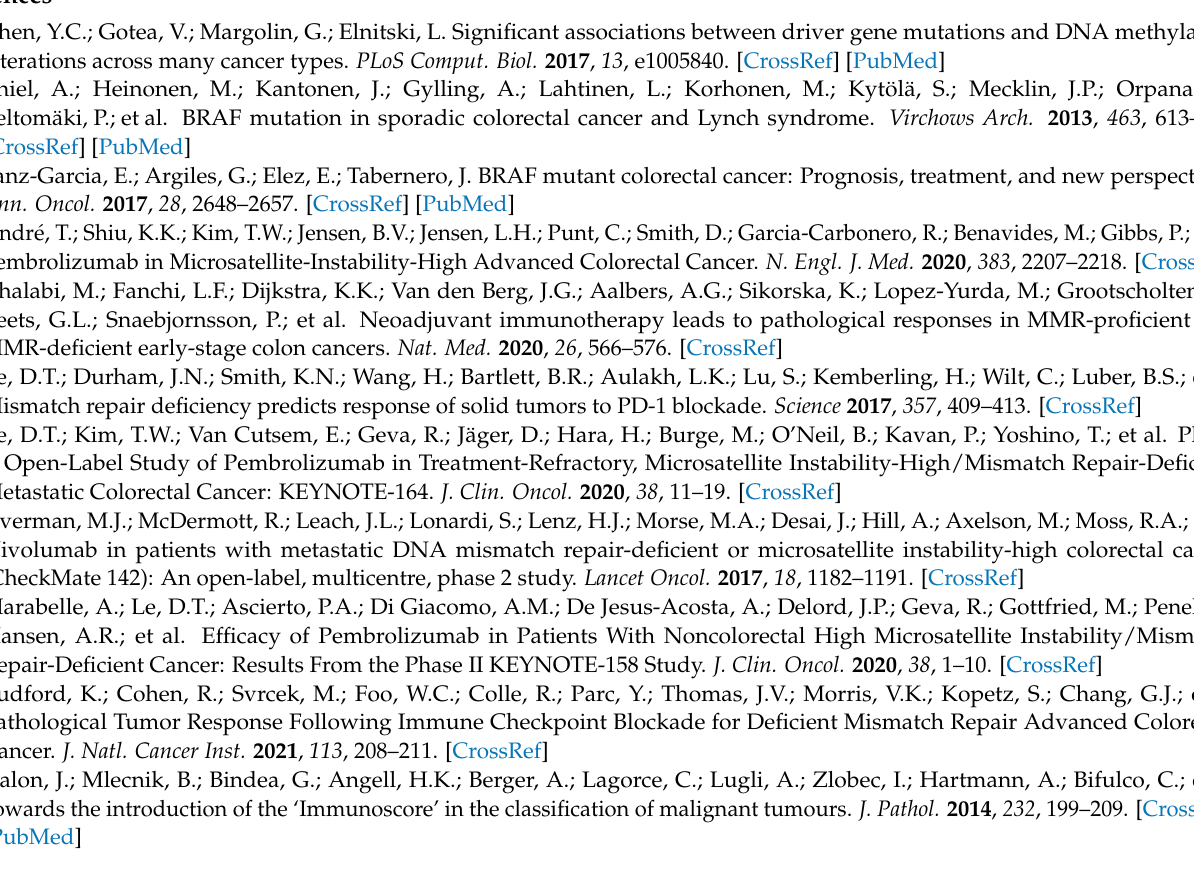
Table S3: “All Signatures” and “All Genes” results tables used to generate the Figure 2a,b, Table S4: “All Signatures” and “All Genes” results tables used to generate the Figure 2c,d, Table S5: Overall survival